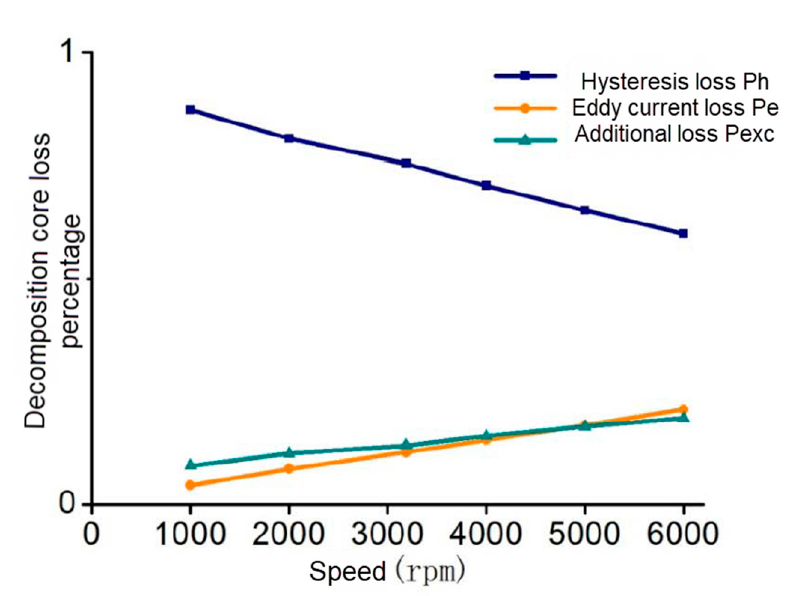
Figure 13. The ratio of core loss to total core loss under different speeds under load conditions.